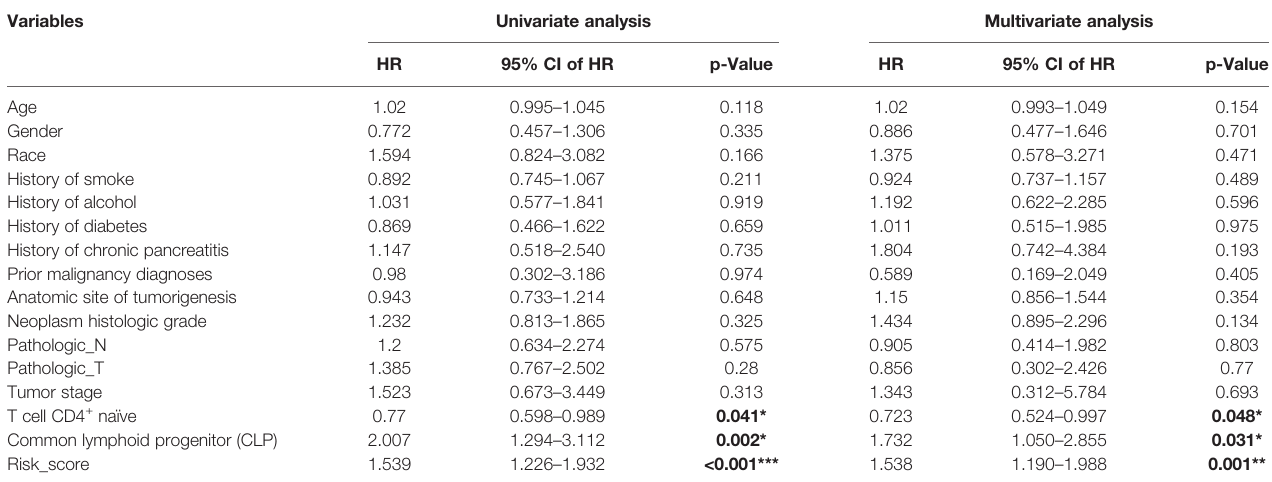
TABLE 2 | Univariate and multivariate analyses for CD4 + T N , CLP, and risk score.